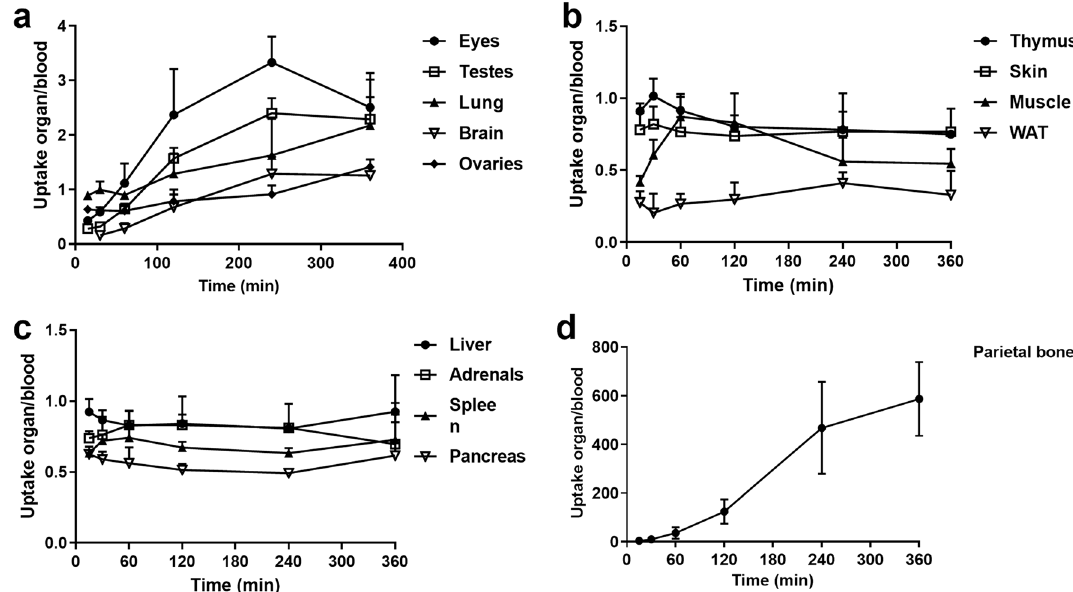
Fig. 5 Ex vivo organ‑to‑blood ratios of [ 18 F]fluoride at 15, 30, 60, 120, 240, and 360 min after injection. a Ratios increased in the eyes, testes, lung, brain, and ovaries. b Ratios remained unchanged over the studied 6 h in white adipose tissue (WAT), skin, muscle, and thymus, and c in liver, adrenals, spleen, and pancreas. d The parietal bone‑to‑blood ratio increased over the 6 h time course. Values are the mean ovary and n 6/time point for other =